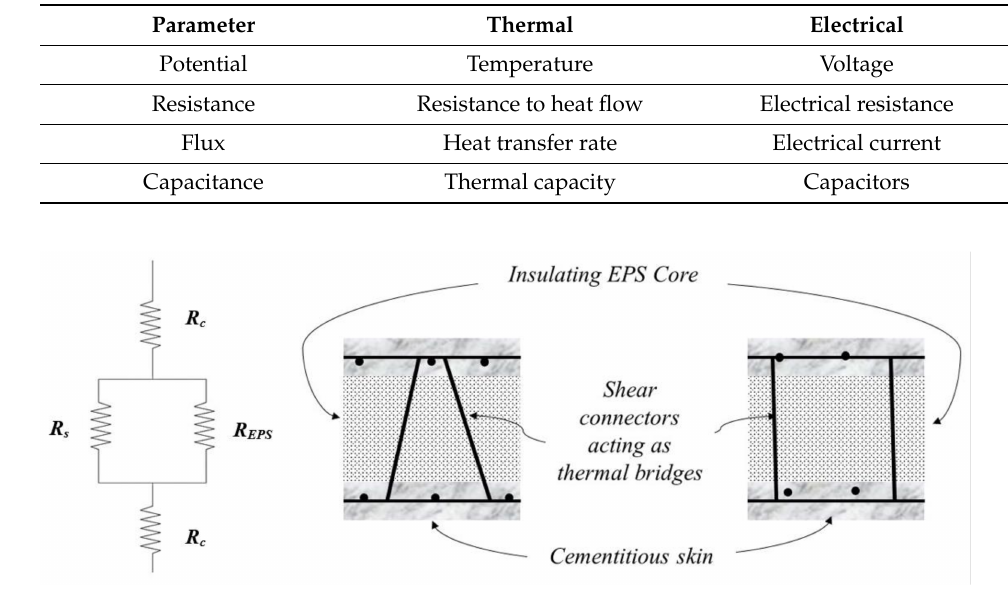
Figure 9. Equivalent thermal circuit for a typical CSP